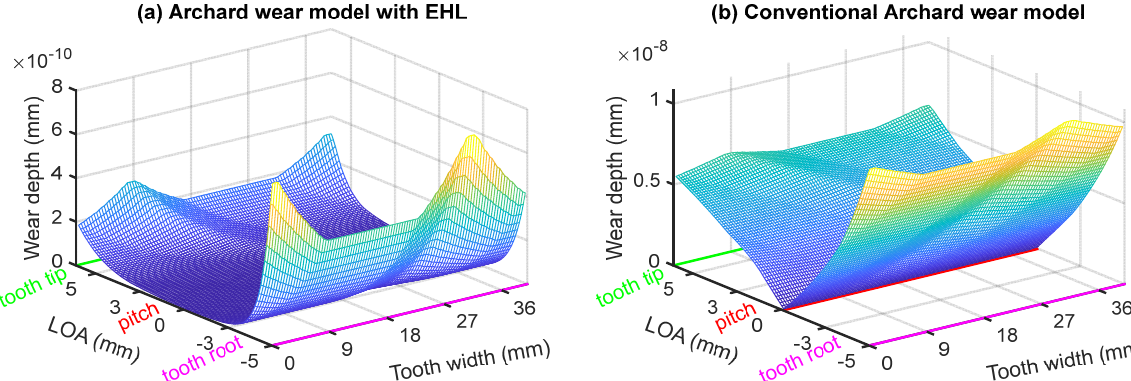
Figure 6. Wear depth of the driving gear under. ( a ) Wear depth derived from Archard wear model with EHL; ( b ) Wear depth derived from conventional Archard wear model.